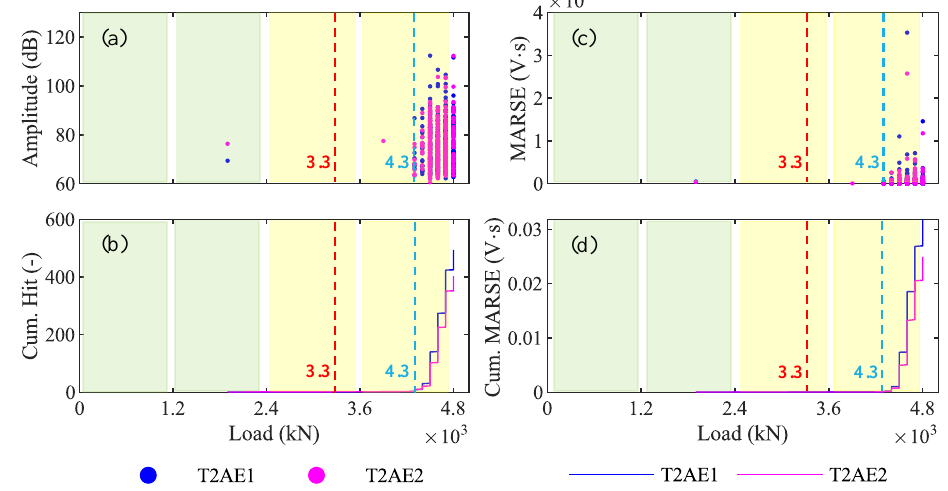
Figure 13. Results in the time-domain from the loading phase P3 4800 kN: ( a ) amplitude; ( b ) cumulative number of hits; ( c ) signal strength; and ( d ) cumulative signal strength.